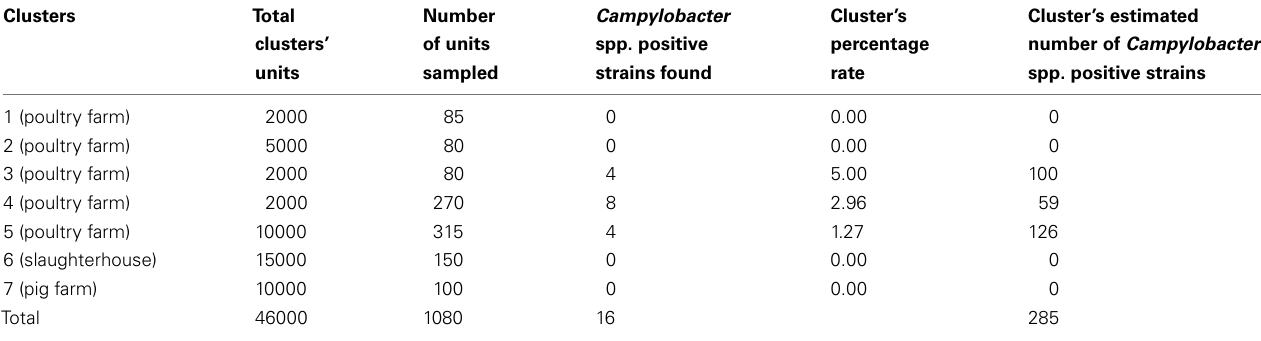
Table 1 | Prevalence rates of Campylobacter spp. isolated from poultry and other animal sources.